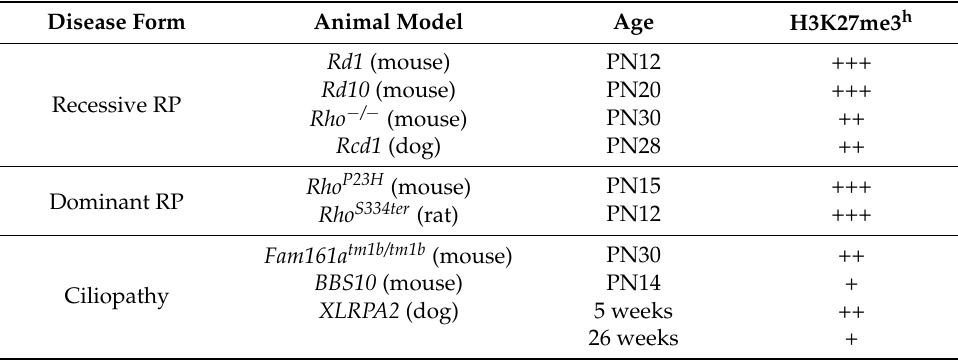
Table 1. Animal models expressing H3K27me3 h during retinal